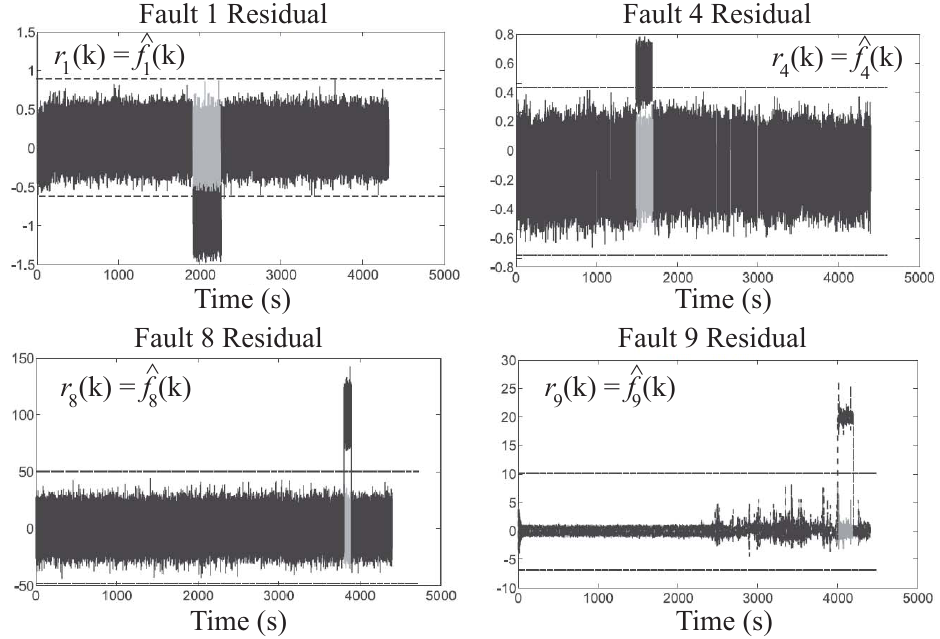
Figure 5. The estimated faults ˆ f i for Cases 1, 4, 8, and